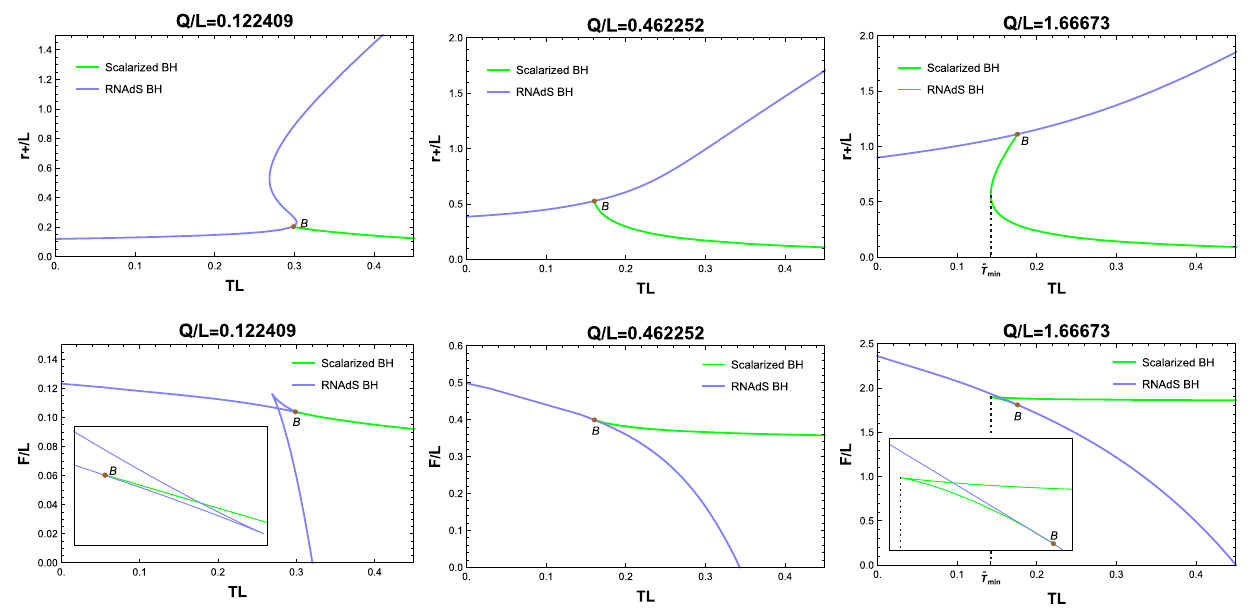
Fig. 4 Plots of the reduced horizon radius ˜ r + (the upper row) and the reduced free energy ˜ F (the lower row) versus the reduced temperature ˜ T for RNAdS (blue lines) and scalarized (green lines) black holes with several fixed values of the reduced charge ˜ Q . Here, we focus on α = 5. Bifurcation points are labeled by B . When ˜ r + ( ˜ T ) is multivalued, black hole solutions have more than one branch of different horizon radii in a canonical ensemble with fixed ˜ T and ˜ Q . Left column: there is a band of temperatures where three branches of RNAdS black hole solu- tions coexist, and a first-order phase transition occurs between the large RNAdS BH phase (i.e., the branch with the largest horizon radius) and the small RNAdS BH phase (i.e., the branch with the smallest hori- zon radius). Scalarized black holes emerge from the bifurcation